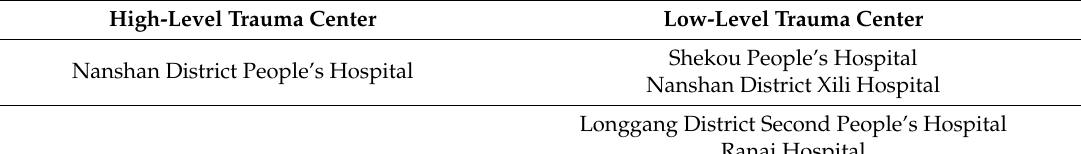
Table 6. List of emergency service allocations of trauma